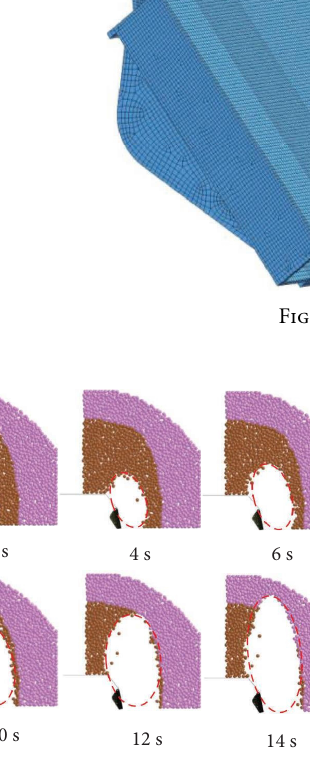
Figure 7: Forms of the released body in diferent stages of coal caving.